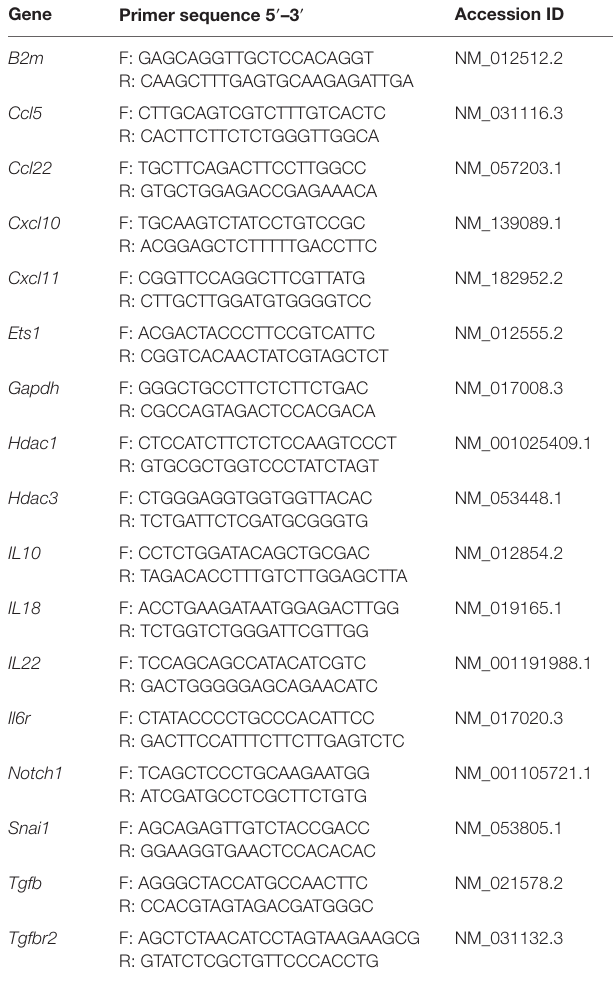
TaBle 1 | list of primers for mrna expression